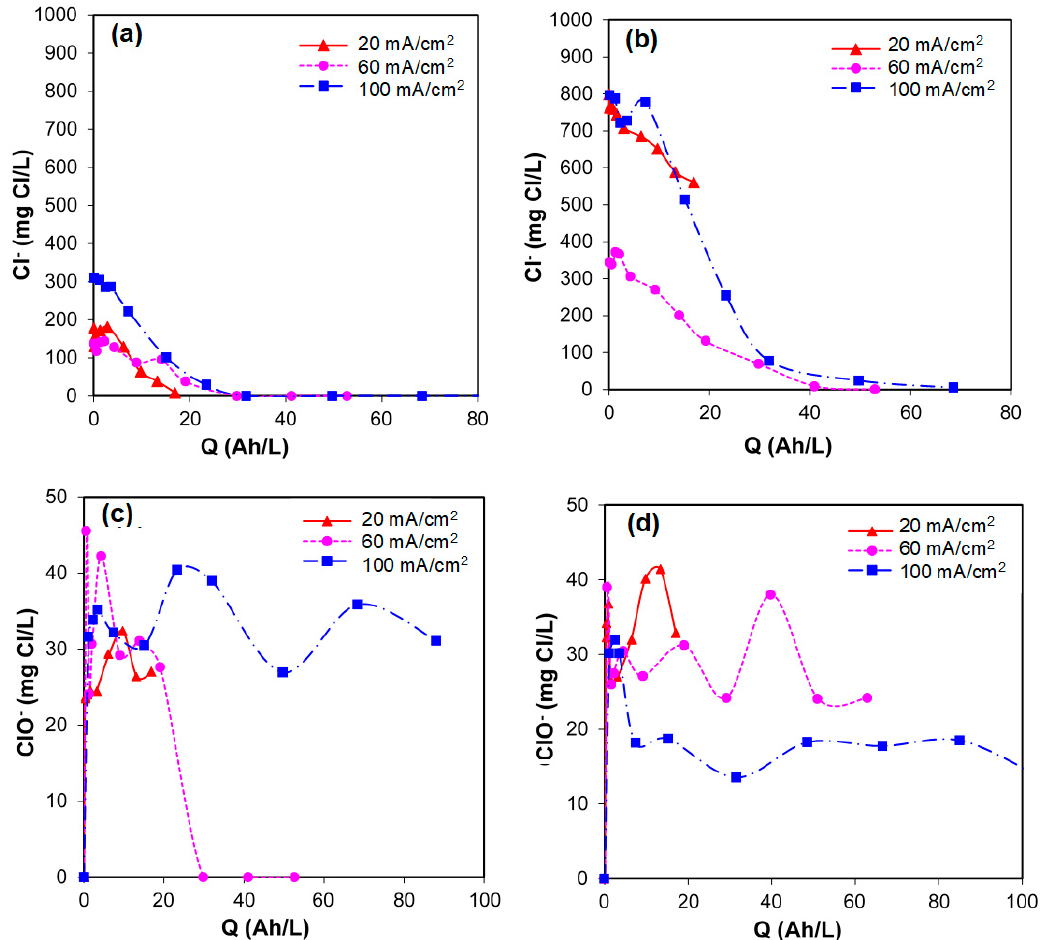
Figure 7. Changes in concentrations of ( a , b ) chlorides (Cl − ) and ( c , d ) hypochlorite (ClO − ) with the specific electric charge during electrolytic treatment of synthetic urine at pH = 5.5 and at room temperature (25 °C) using BDD ( a , c ) and DSA ( b , d ) anodes and a stainless steel cathode with a flow rate of 800 mL/min at different current densities: ( ▲ ) 20 mA/cm 2 , ( ● ) 60 mA/cm 2 , and ( ■ ) 100 mA/cm 2 . Chlorides concentration started to decay from the beginning of the treatment, at the same time, hypochlorites concentration increased. BDD achieved a complete depletion of chlorides for all the current densities at 20–30 Ah/L, whereas DSA achieved the total depletion of chlorides only for current densities higher than 20 Ah/L and after consumption of 40 Ah/L. Similar amounts of